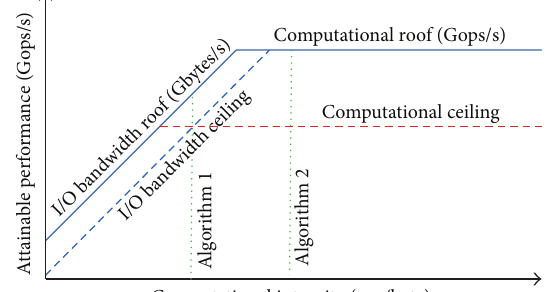
Figure 1: Basis of the roofline model. Considering two applications with a different CI, they are either compute or I/O